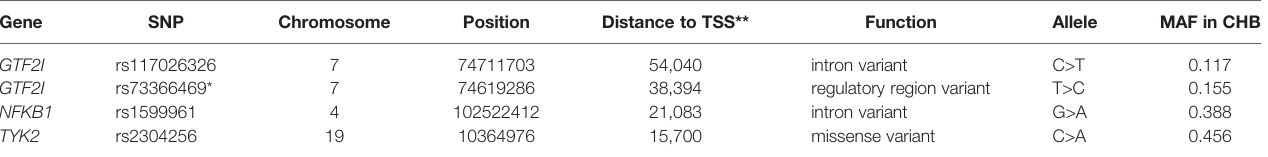
TABLE 2 | Characteristics of four